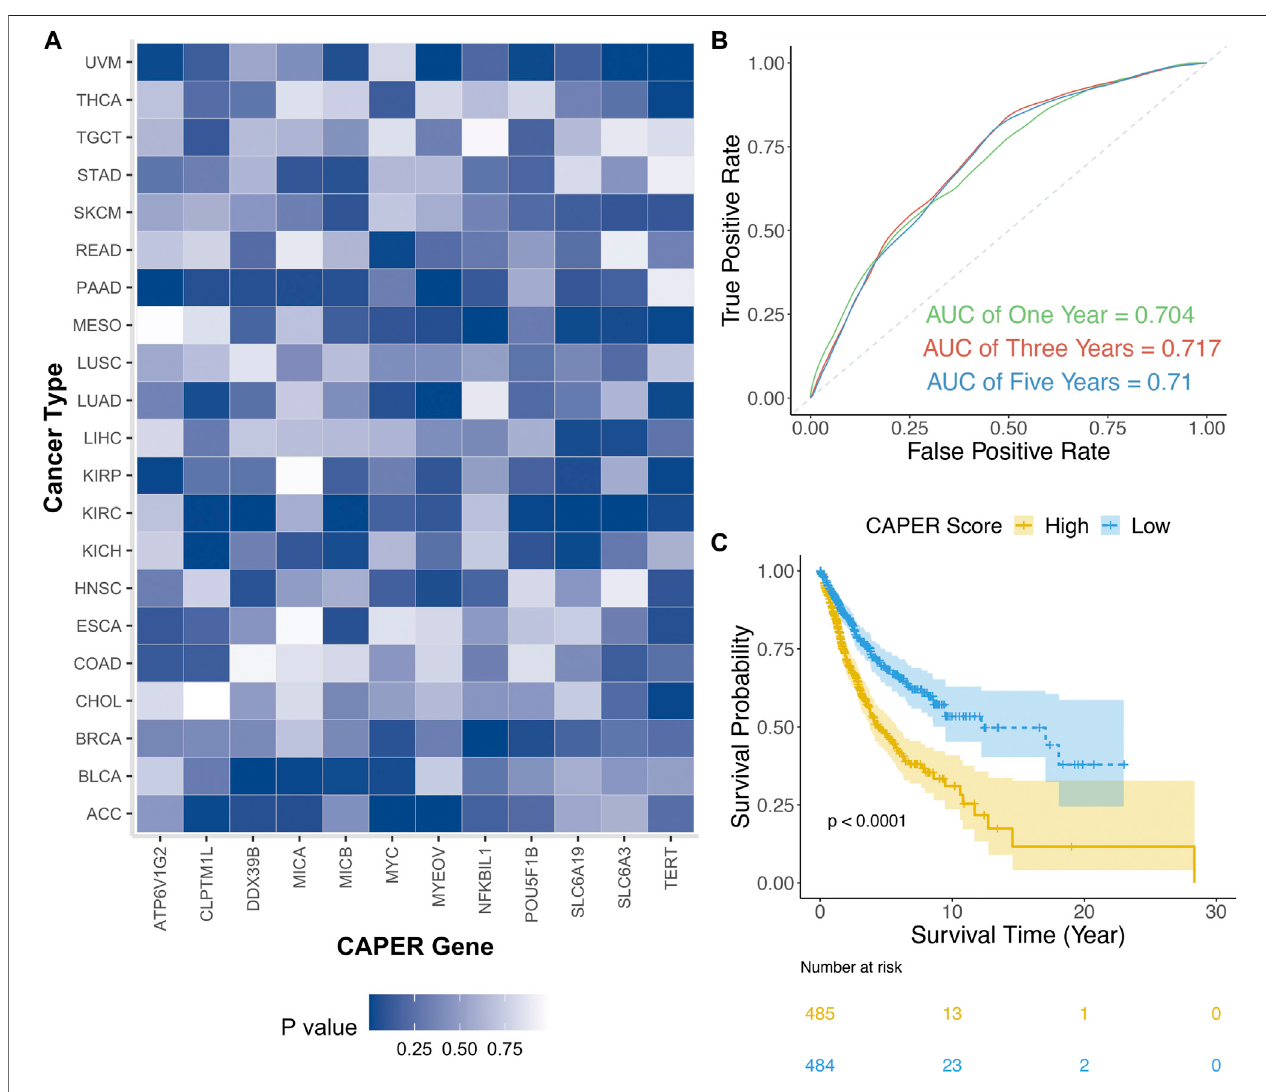
FIGURE 3 | Summary of the CAPER score. (A) Heatmap showing the p -value of each CAPER gene in the univariate Cox regression performed on each type of cancer. (B) ROCofthemultivariateCoxregressionconductedontheTCGAtestset.WeestimatedtheAUCof1-year(green),3-year(Red),and5-year(Blue)survival. (C) K-M curve of the high- and low-CAPER score groups. The HR of the CAPER score was statistically signi fi cant to the survival time with a p -value of < 0.001 and was adjusted for age, sex, and tumor stage.